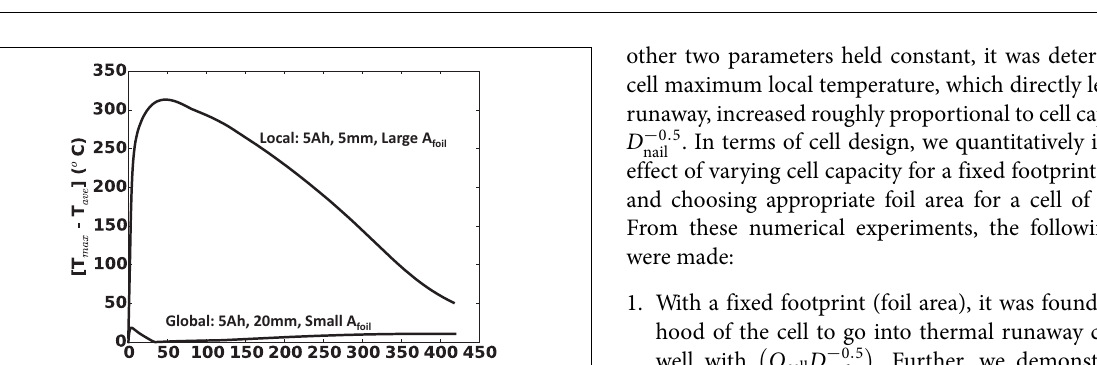
FIGURE 9 | Maximum local temperature versus single sheet foil area for (A) 5, (B) 10, (C) 20, and (D) 30Ah cells . Blue circle = 5mm nail, red triangle = 10mm nail, green square = 15mm nail, and black pentagon = 20mm nail.